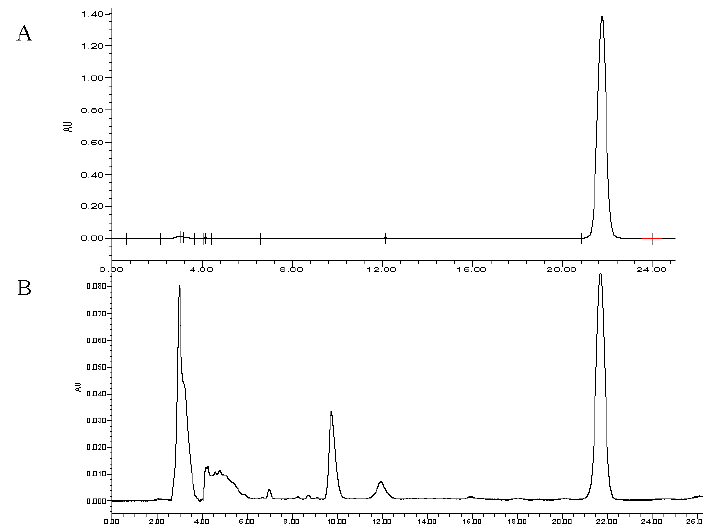
Figure 1. ( A ) HPLC chromatogram of psoralen standard. ( B ) HPLC chromatogram of psoralen in F. tikoua fruit.